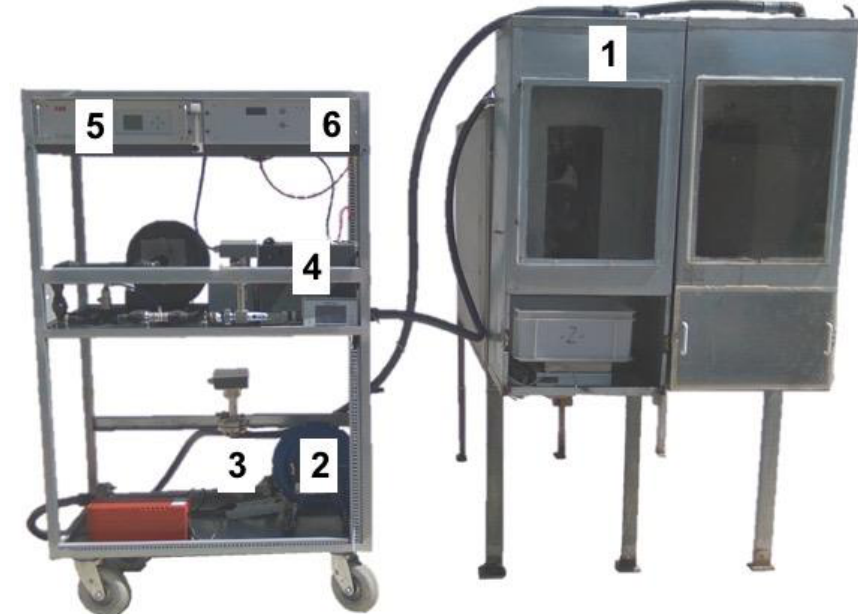
Figure 1. Mobile open-circuit indirect calorimetry equipment cart. (1) Head hood, (2) fan, (3) mass flowmeter, (4) gas cooler, (5) gas analyzer (oxygen, carbon dioxide and methane), (6) box for system control and data acquisition panel.